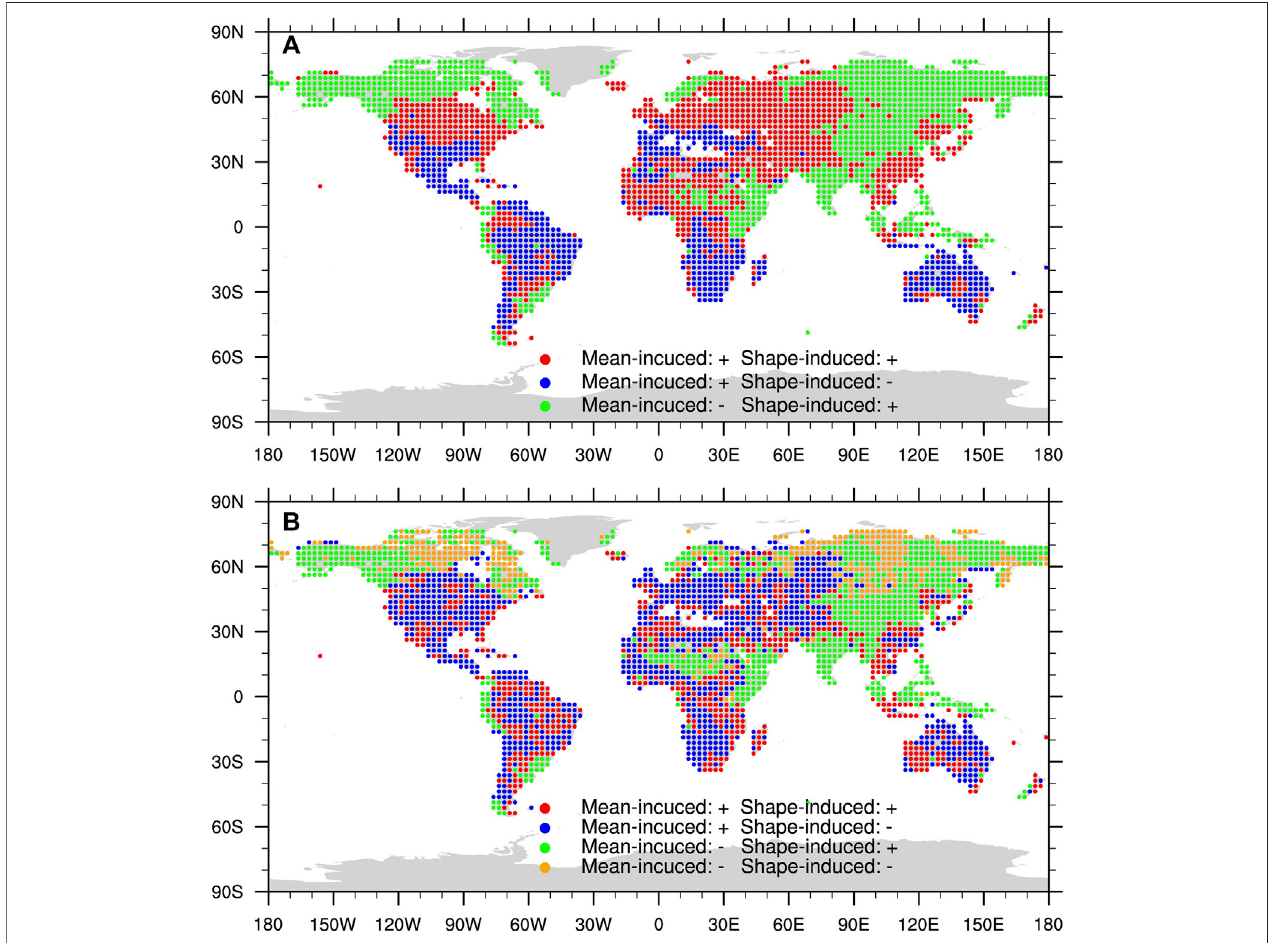
FIGURE 3 | Spatial distribution of the signs of (A) severe and (B) moderate drought frequency changes due to the PDSI PDF mean and shape changes following Figures 2A,B and Figures 2D,E . Red dots indicate positive changes due to both mean and shape (Type I). Blue dots indicate positive change due to the mean but negativechangeduetotheshape(TypeII).Greendotsindicatenegativeduetothemeanbutpositiveduetotheshape(TypeIII).Orangedotsin (B) indicatenegativedue to both mean and shape (Type IV).